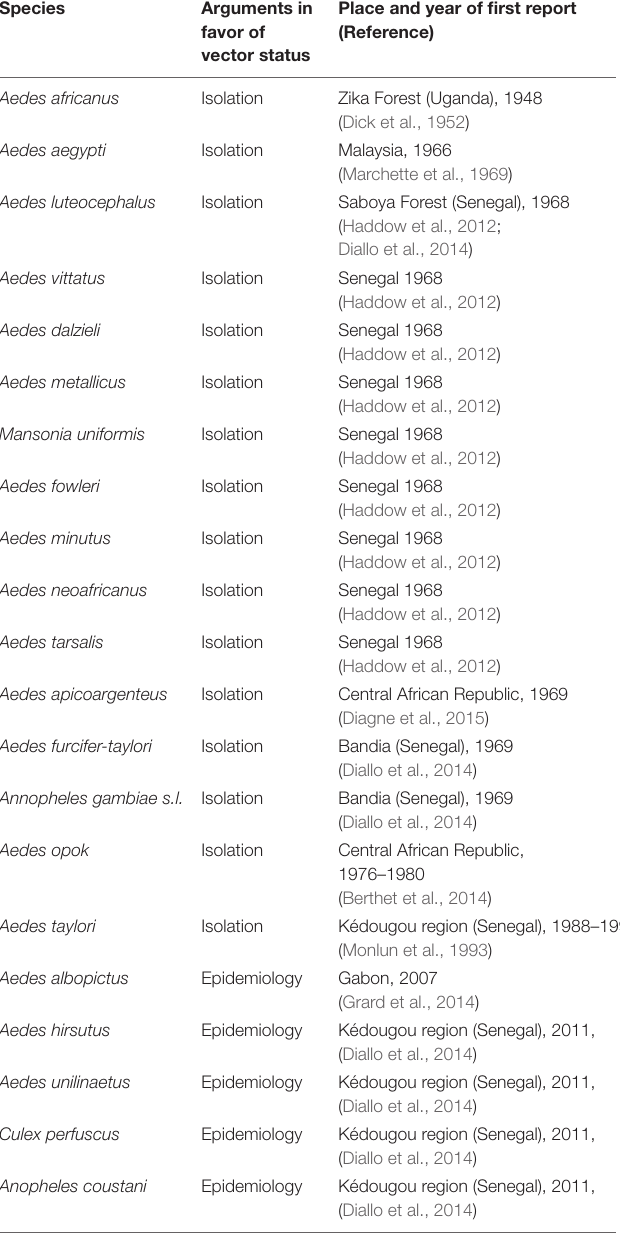
TABLE 1 | Zika vector mosquito